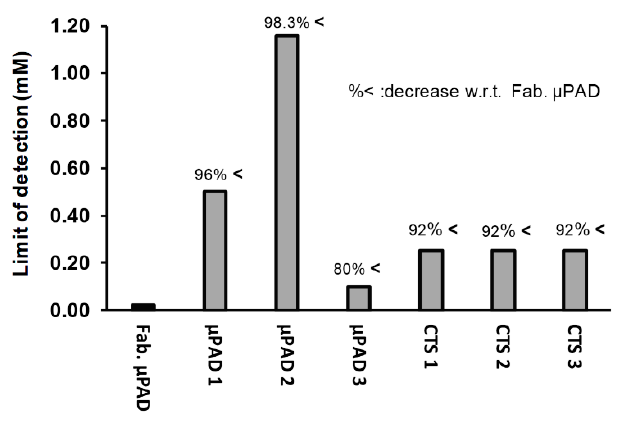
Figure 7. Comparison of the limit of detection (LOD) of the fabricated µPAD (Fab. µPAD) with µPAD 1 (fabricated by Karita and Kaneta [22]), µPAD 2 (fabricated by Shariati-Rad and Heidari [49]), µPAD 3 (fabricated by Ostad et al. [50]), CTS 1 (Commercial Test Strip manufactured by Honeforest [51]), CTS 2 (Commercial Test Strip manufactured by Health Metric [52]), and CTS 3 (Commercial Test Strip manufactured by Thomas Scientific